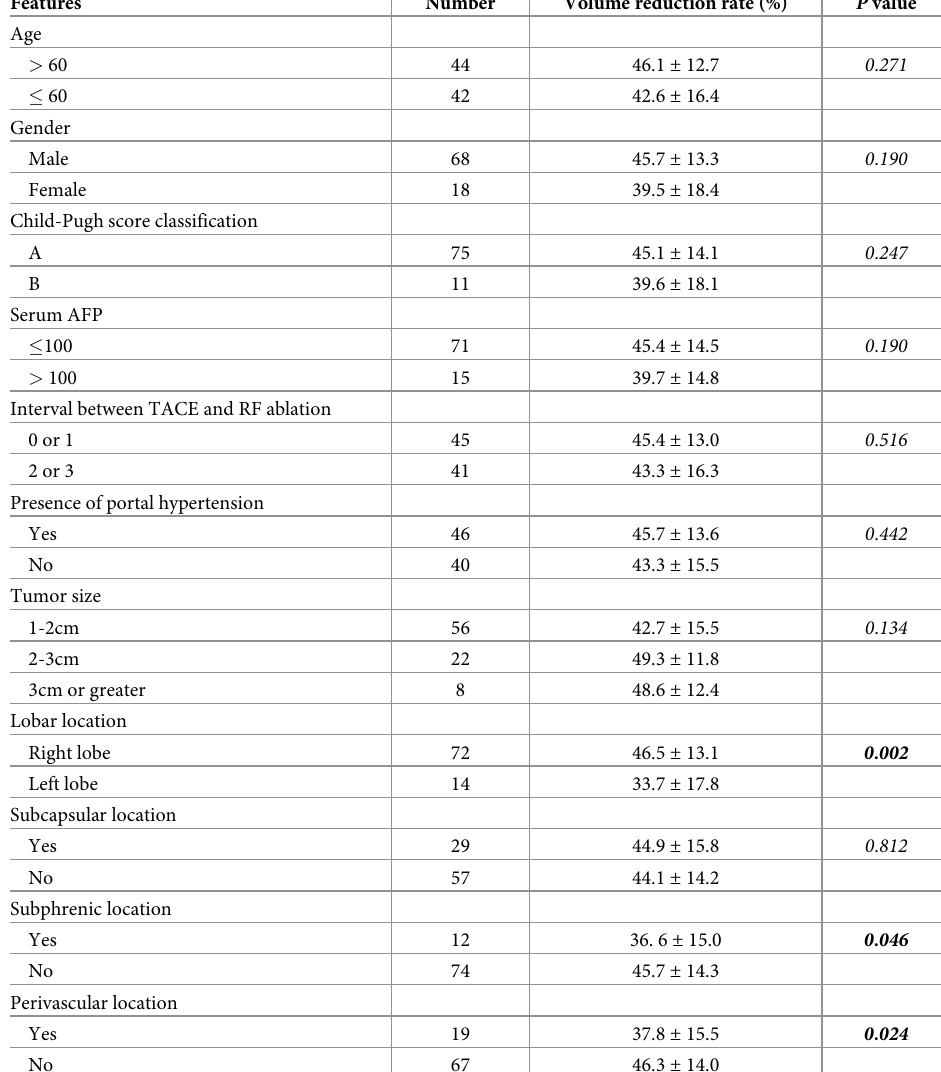
Table 3. Relations between clinical or imaging features and volume reduction rates of hepatocellular carcinoma after radiofrequency ablation.